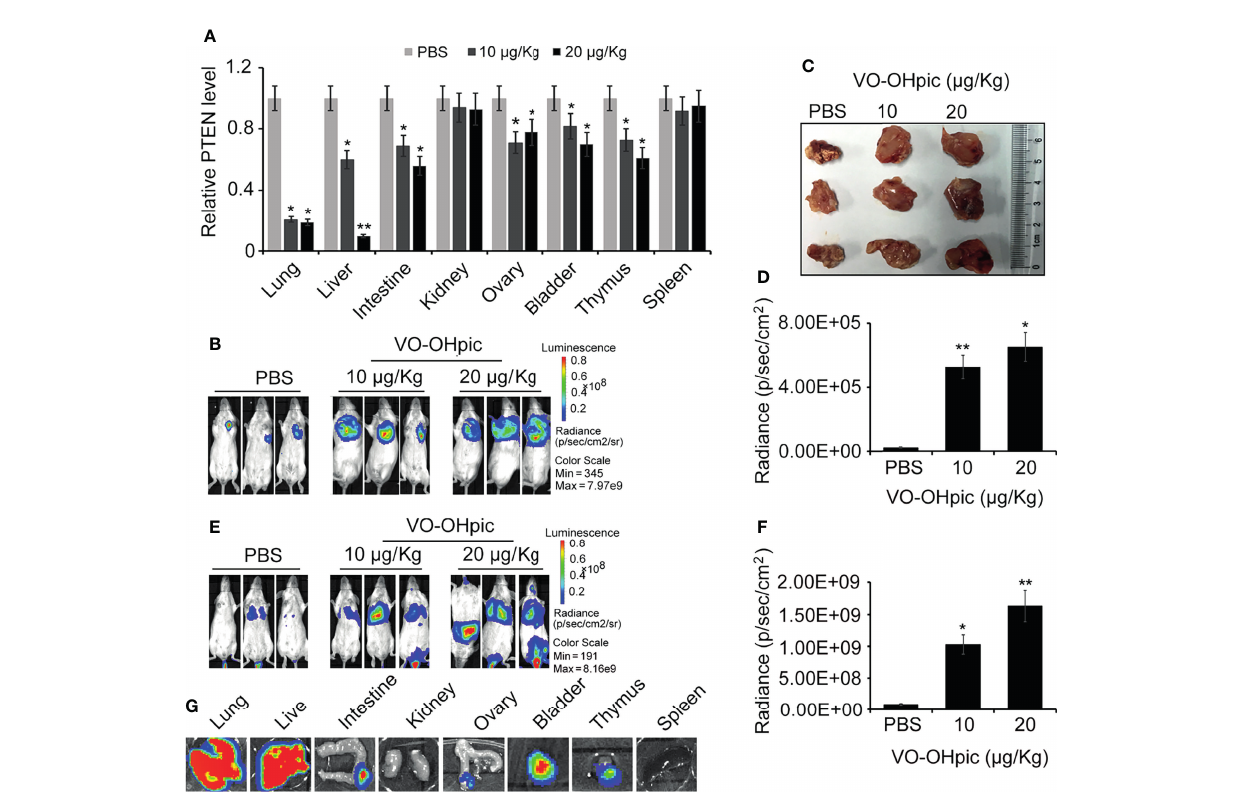
FIGURE 4 | Inhibition of PTEN in mice promoted the metastasis and proliferation of 4T1-luc cells in mice. Expression levels of PTEN mRNA in some organs of Balb/ c mice were affected by intraperitoneal injection of 10 or 20 m g/kg VO-OHpic for 1 h, as detected by real-time PCR (A) . Routine cultured 4T1-luc cells were inoculated into the breast fat pad of mice treated as above to establish an in situ tumor model and tumor formation was observed at 10 days using an IVIS (B) . Some exfoliated tumor tissues in situ were imaged (C) . A metastatic breast cancer model was established by injecting 4T1-luc cells into the tail vein (E) . PTEN inhibition by intraperitoneal injection of VO-OHpic in vivo signi fi cantly increased the counts of bioluminescent photons in situ breast tumors (D) and visceral metastases (F) . Bioluminescence of metastatic tumors in organs including the lung, liver, and intestine were observed using an IVIS (G) . Compared with control group, * P <0.05, ** P